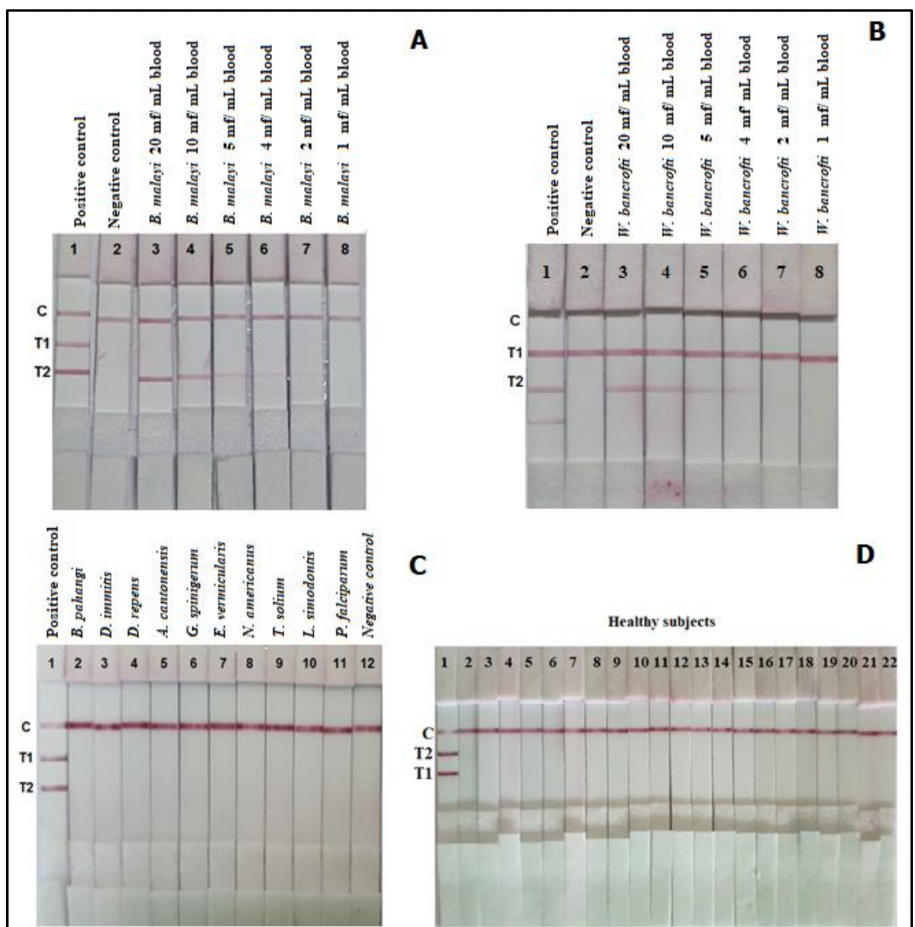
Figure 4. The detection limit of the miniPCR-DLFD using blood samples spiked with various numbers of B. malayi mf per mL blood ( A ); W. bancrofti mf per mL blood ( B ); and the specificity of the miniPCR-DLFD verified with DNA templates of other parasites ( C ) and DNA templates of healthy subjects ( D ). T1 = detection zone for Brugia malayi DNA; T2 = detection zone for Wuchereria bancrofti DNA; C = control line.